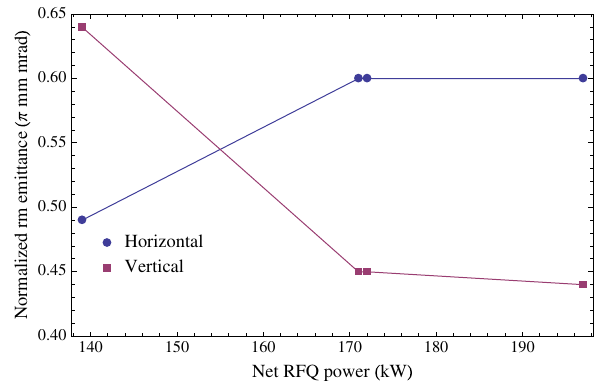
FIG. 32. The effect on emittance as a function of RFQ power. The emittances stabilize above 170 kW.